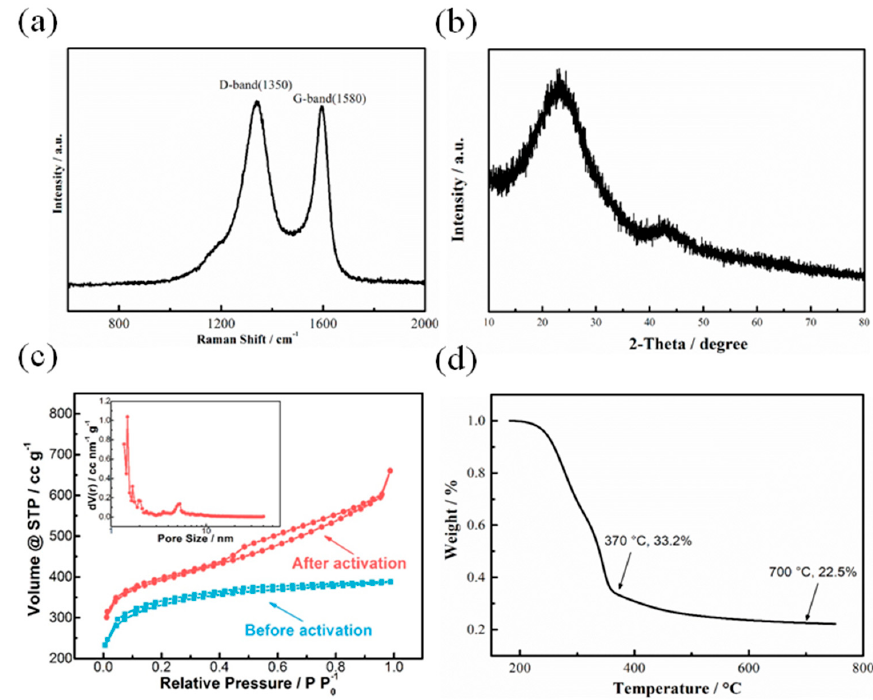
Figure 3. ( a ) Raman spectrum and ( b ) XRD pattern of pyrolyzed-activated carbon materials; ( c ) N 2 gas adsorption–desorption curve of pyrolyzed carbon materials before and after activation; ( d ) TGA curve of corncob pyrolysis, the inset of ( c ) is the corresponding pore size distribution curve of pyrolyzed-activated carbon materials.